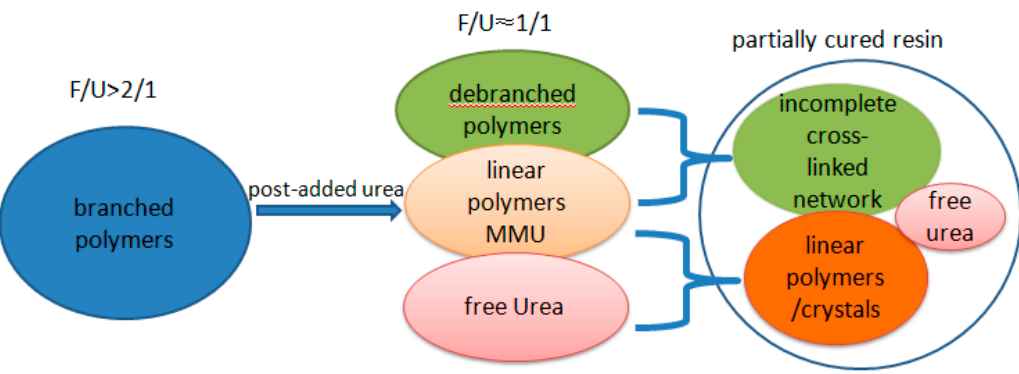
Figure 7. The postulated cure pattern of low-molar ratio urea-formaldehyde (UF) resin.